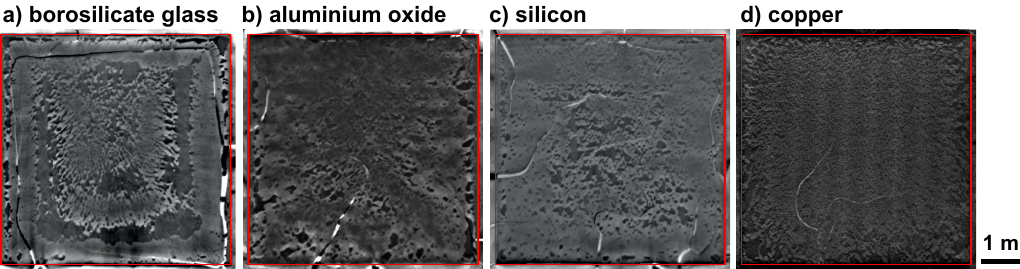
Figure 2. CT scans (inverted grayscale) of joints prepared by reactive joining for ( a ) borosilicate glass; ( b ) Al 2 O 3 ; ( c ) Si; and ( d ) Cu, showing the region of the solder layer between the RF and the upper substrate plate. The red box defines the position of the upper substrate plate (4 mm × 4 mm). Pores (darker regions) are present in the solder layer, as well as cracks (dark lines) in the reactive foil layer, which are partially filled with solder (bright